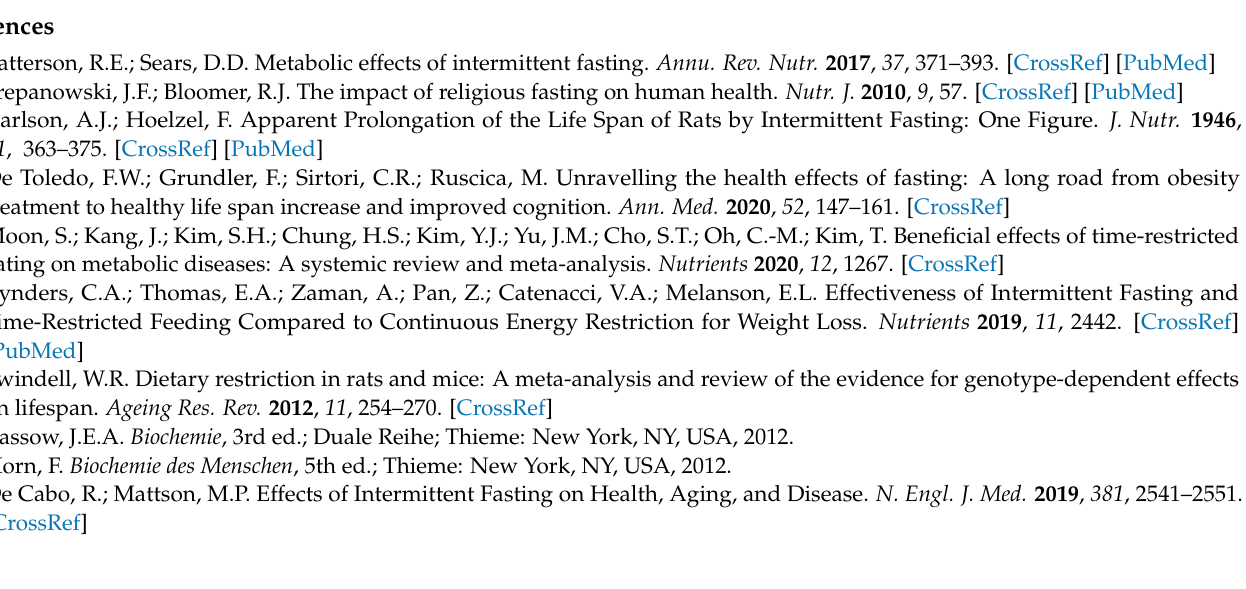
Figure S3: Fatigue Severity Scale (FSS); Figure S4: Fatigue Assessment Scale (FAS); Figure S5: Baseline characteristics: